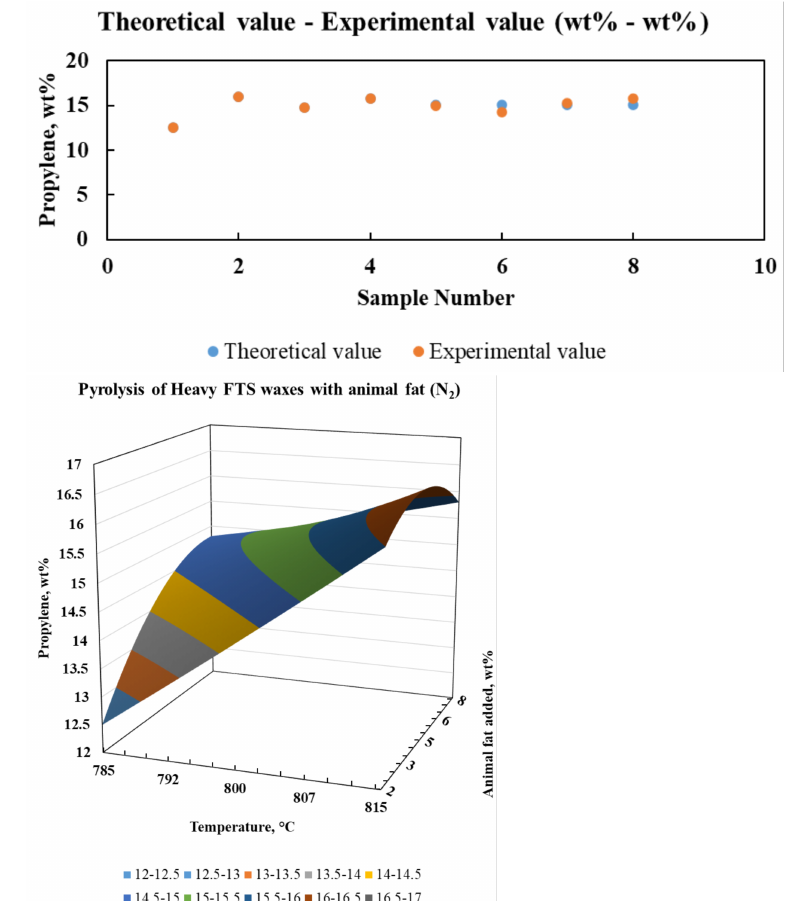
Figure 3. Theoretical and experimental difference values for the propylene content in the product and the response surface for the tests with heavy FTS